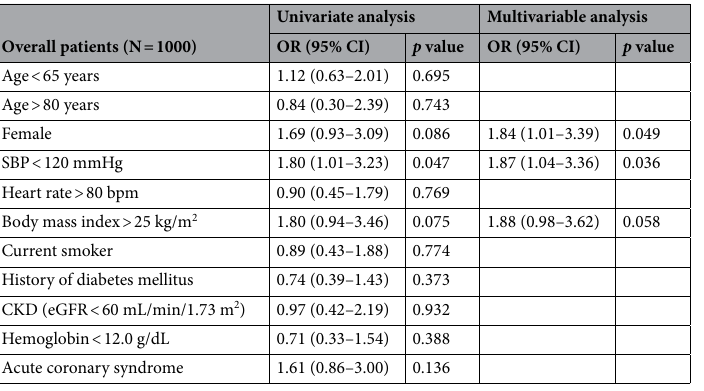
Table 3. Predictors of distal radial access failure. SBP Systolic blood pressure, CKD Chronic kidney disease, eGFR Estimated glomerular filtration rate.